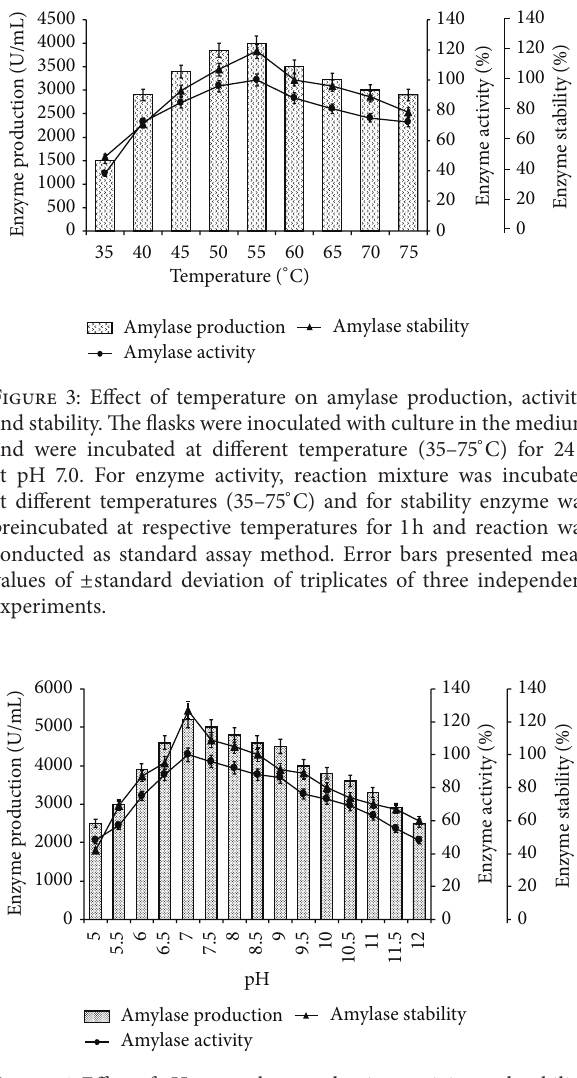
Figure 4: Effect of pH on amylase production, activity, and stability. The flasks were inoculated with culture and were incubated at different pH (5–12) for 24 h at 55 ∘ C. For enzyme activity, the reaction was assayed at respective pH and for stability enzyme was preincubated with buffers (100mM, in ratio 1: 1) of different pH (5– 12) at 55 ∘ C for 1 h and assayed by standard assay method. Error bars presented mean values of ± standard deviation of triplicates of three independent